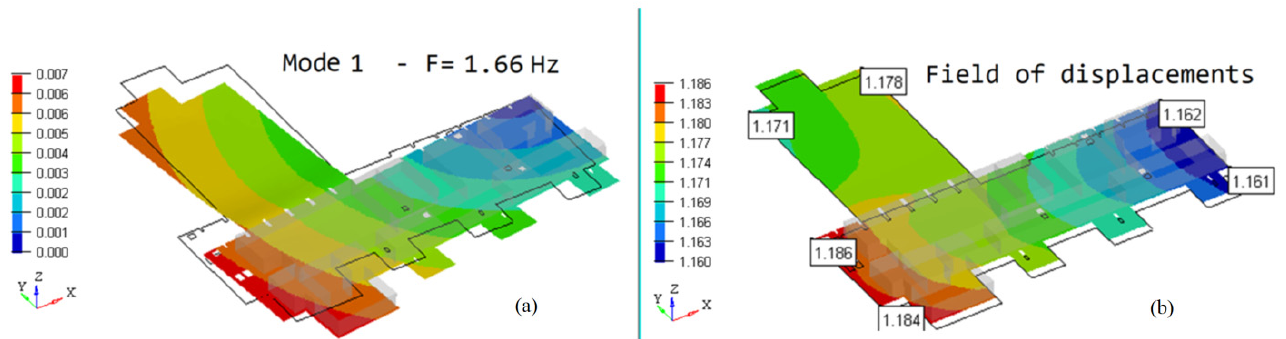
Figure 11. Transmisibility in the center of mass of the platform excited with a harmonic vibration in the OY direction.